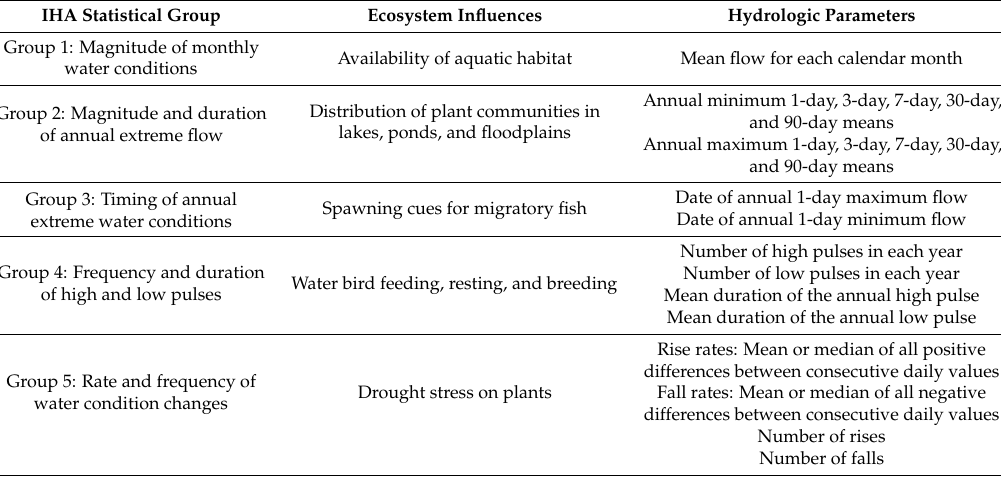
Table 1. Indicators of Hydrologic Alteration